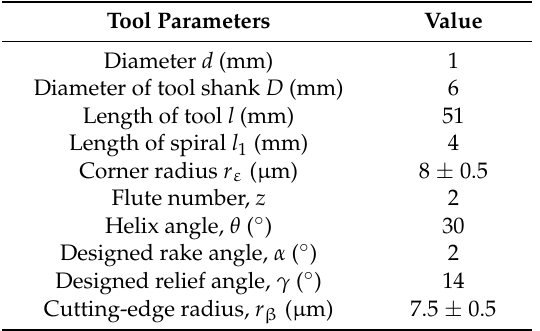
Table 2. Tool parameters of the diamond-coated micro end mill.